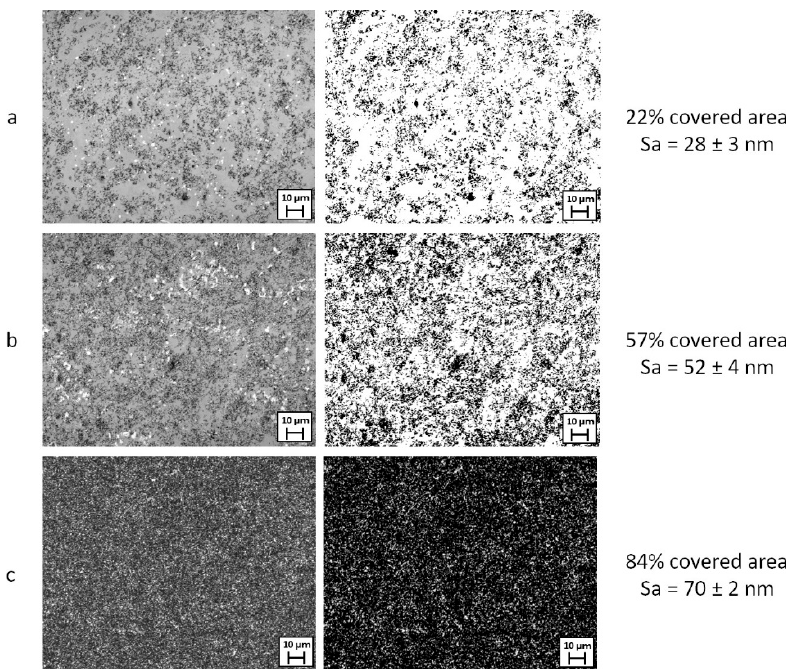
Figure 2. Optical and corresponding binary images of hydrophobic and superhydrophobic samples acquired by 3D interferometric and confocal profilometer Sensofar S-Neox: ( a ) Sa = 28 ± 3 nm (1 g/L 1 layer); ( b ) Sa = 52 ± 4 nm (2 g/L 2 layers); ( c ) Sa = 70 ± 2 nm (0.5 g/L 10 layers). Reference marker 10 μ m.